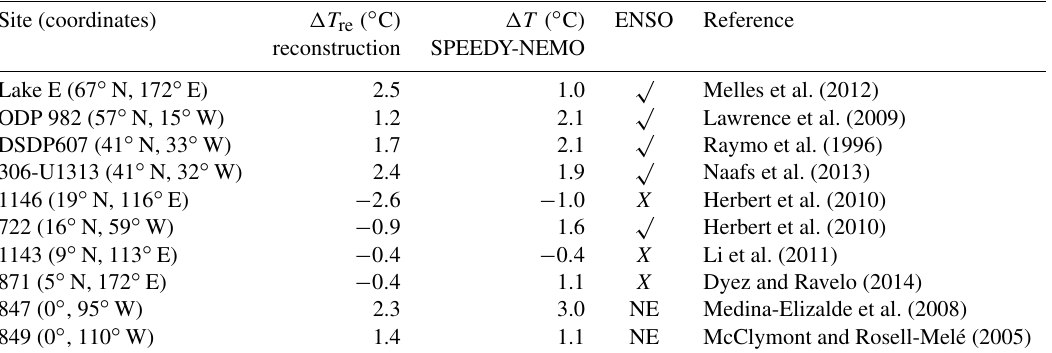
Table 2. Differences in reconstructed SST and Lake E temperatures ( (cid:49)T re ; Wet et al., 2016) and NOAA-SST and ERA-I. Differences √ between MIS31 – CTR SST and Lake E temperatures in JJA ( (cid:49)T ). ( X ) stands for agreement (disagreement) between the (cid:49)T and induced SST anomalies (MIS31-CTR) by regressing the ENSO index. NE indicates that the index was not evaluated at the grid point or anomalies are too close to zero. Based on Wet et al. (2016) and Justino et al. (2017).